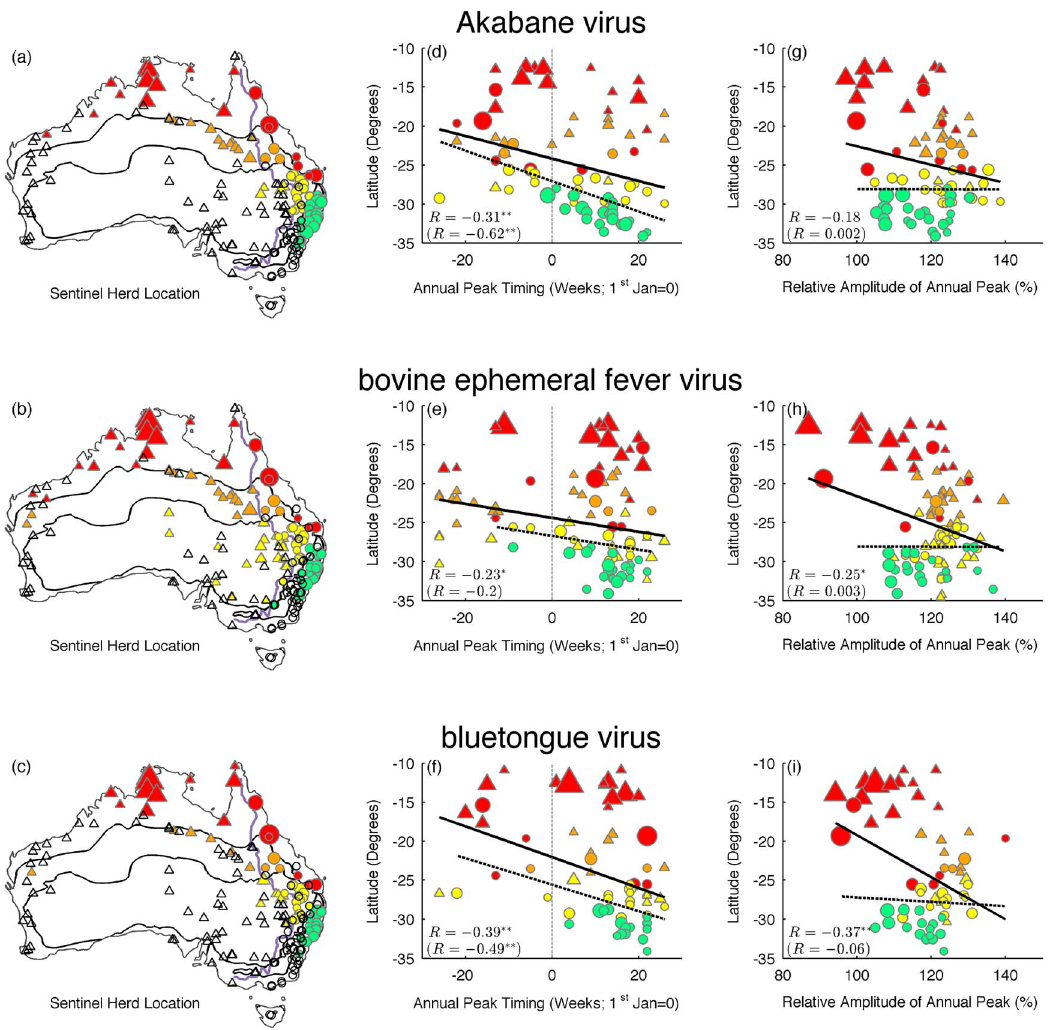
Figure 3. Seasonal parameters as a function of latitude are shown for Akabane virus (top), bovine ephemeral fever virus (middle), and bluetongue virus (bottom). Left panel (a, b, c): estimated mean annual peak timing. Centre panel (d, e, f): estimated amplitude of annual peak, relative to the mean standardized time series. Right panel (g, h, i): map of Australia showing location of sentinel herds. Colors correspond to different climate regions (tropical: red; grasslands: orange; arid: yellow; warm-temperate: green) and shapes correspond to east (circles) and west (triangles) of the Great Dividing Range. Shape size corresponds to the mean number of seroconversions. Open shapes represent sentinel herds for which there has been no detection of these viruses. A black, solid line illustrates a line of best fit through all points while a dashed line shows the best fit through circles only (i.e. east of the Great Dividing Range). Pearson’s R is shown (in parentheses for circles only), and an asterisk indicates whether it is significantly different from zero (*p , 0.05; **p ,